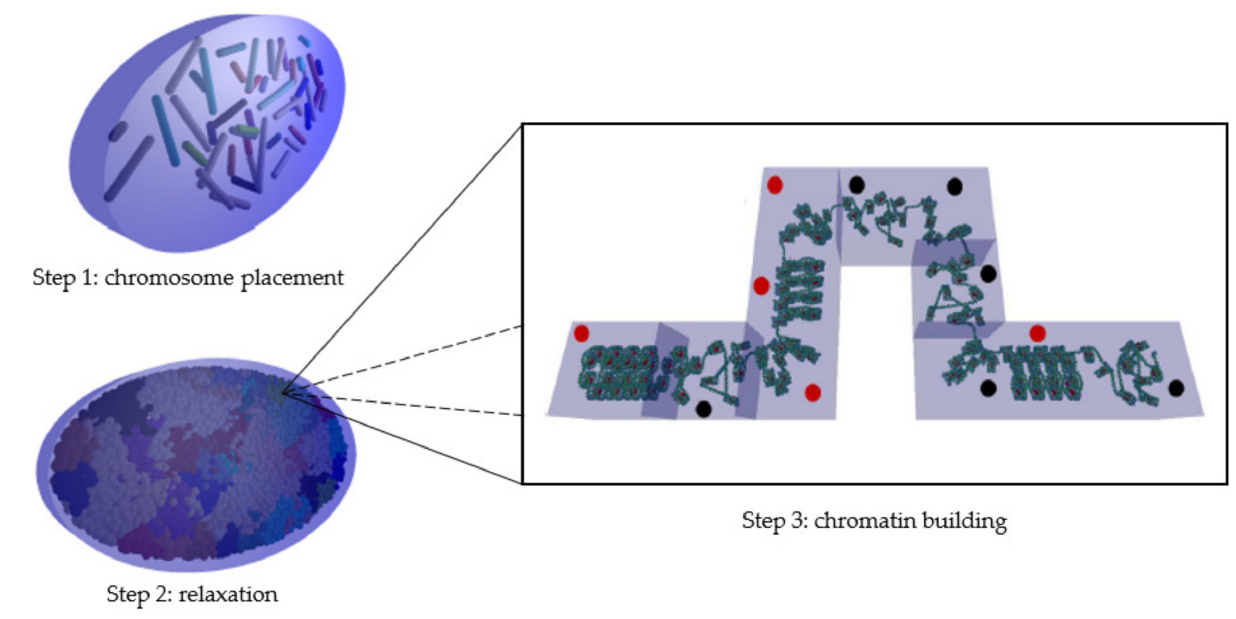
Figure 7. Illustration of the three steps needed to build the endothelial nuclear geometry. In step three, heterochromatin voxels are marked with red dots and euchromatin voxels are marked with black